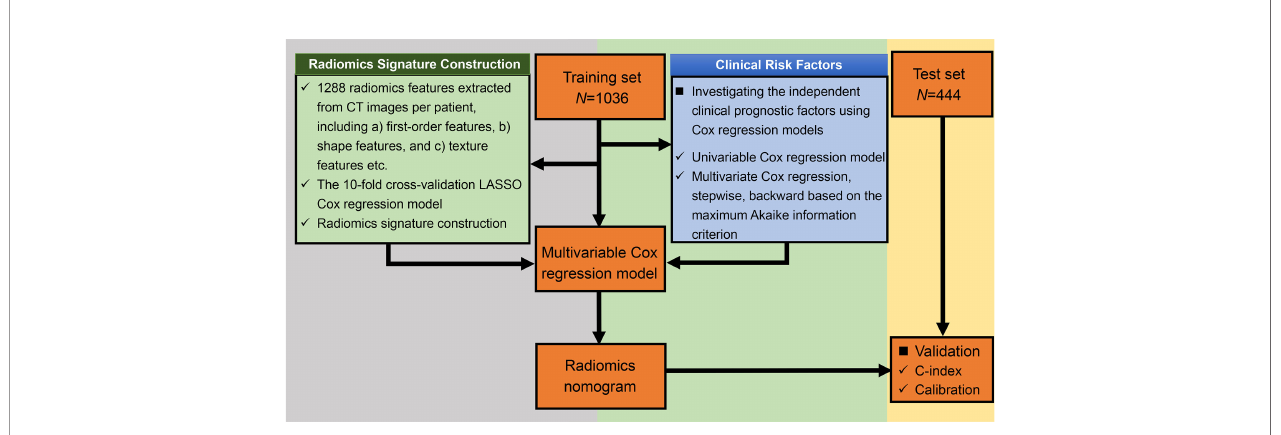
FIGURE 1 | The fl owchart of the